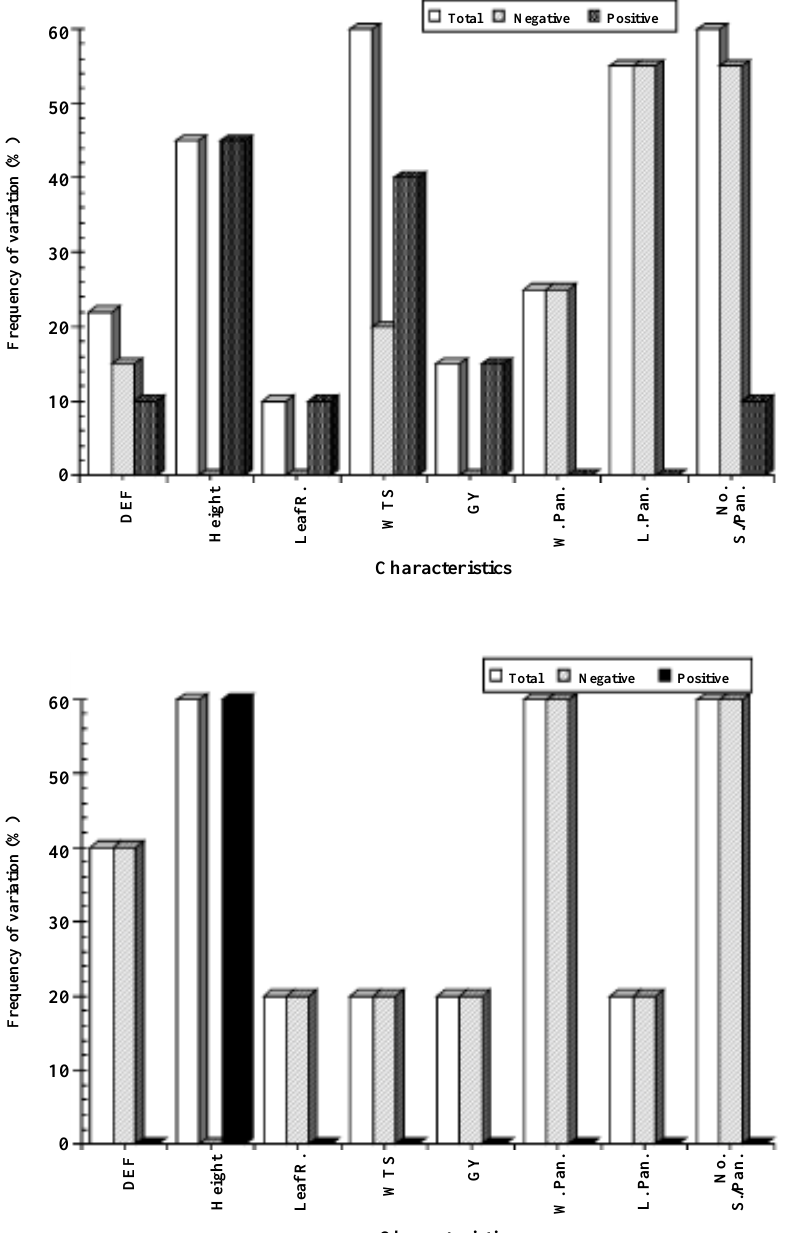
Figure 2 - Frequency of total, negative and positive varia- tion for eight characteristics evaluated in oat soma- clones derived from cultivar UPF 89S080. EEA/UFRGS, 1993. For abbreviations, see legend to Figure